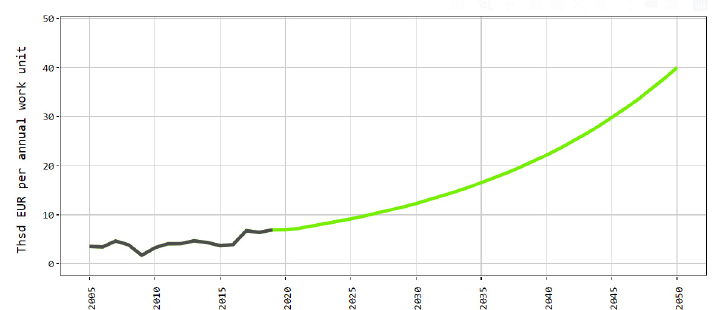
Figure 23. Value added per employed in specialized dairy farms in 2005–2019, and a 2020–2050 projection for Latvia, in thousands of EUR [62].